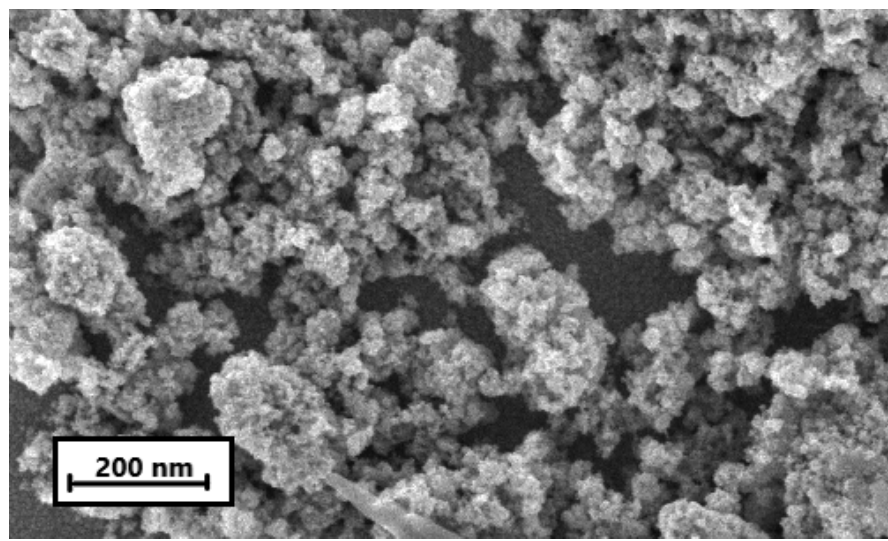
Figure 2. Scanning electron microscope (SEM) image of dropcast CdS nanoparticles (scale bar is 200 nm).